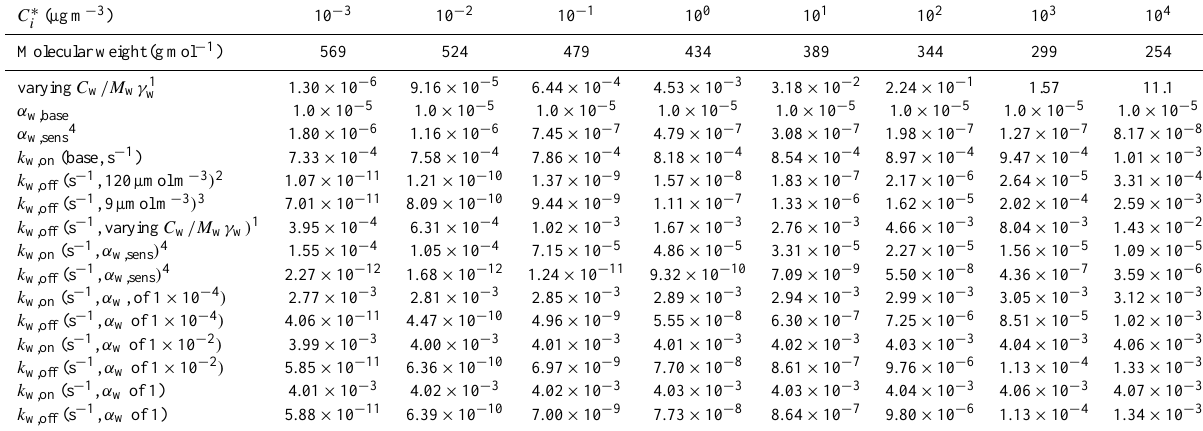
Table 3. Molecular weight (gmol − 1 ) associated with each vapor pressure bin, computed for a temperature of 298K following the calculation equation in Table 2, varying C w /M w γ w as a function of vapor pressure bins, wall-loss rates (s − 1 , k w,on and k w,off for 120, 9µmolem − 3 and varying C w /M w γ w ) and accommodation coefficients between gas and wall ( α w ) for each volatility bin in the base-assumption simulation and the sensitivity